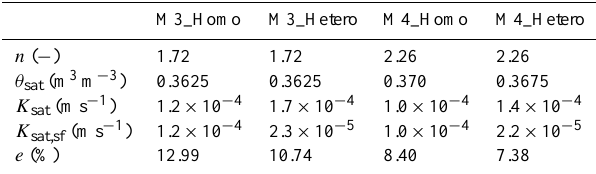
Table 2. Optimized parameter values for K sat , K sat,sf , and θ sat and mean relative errors ( e ;